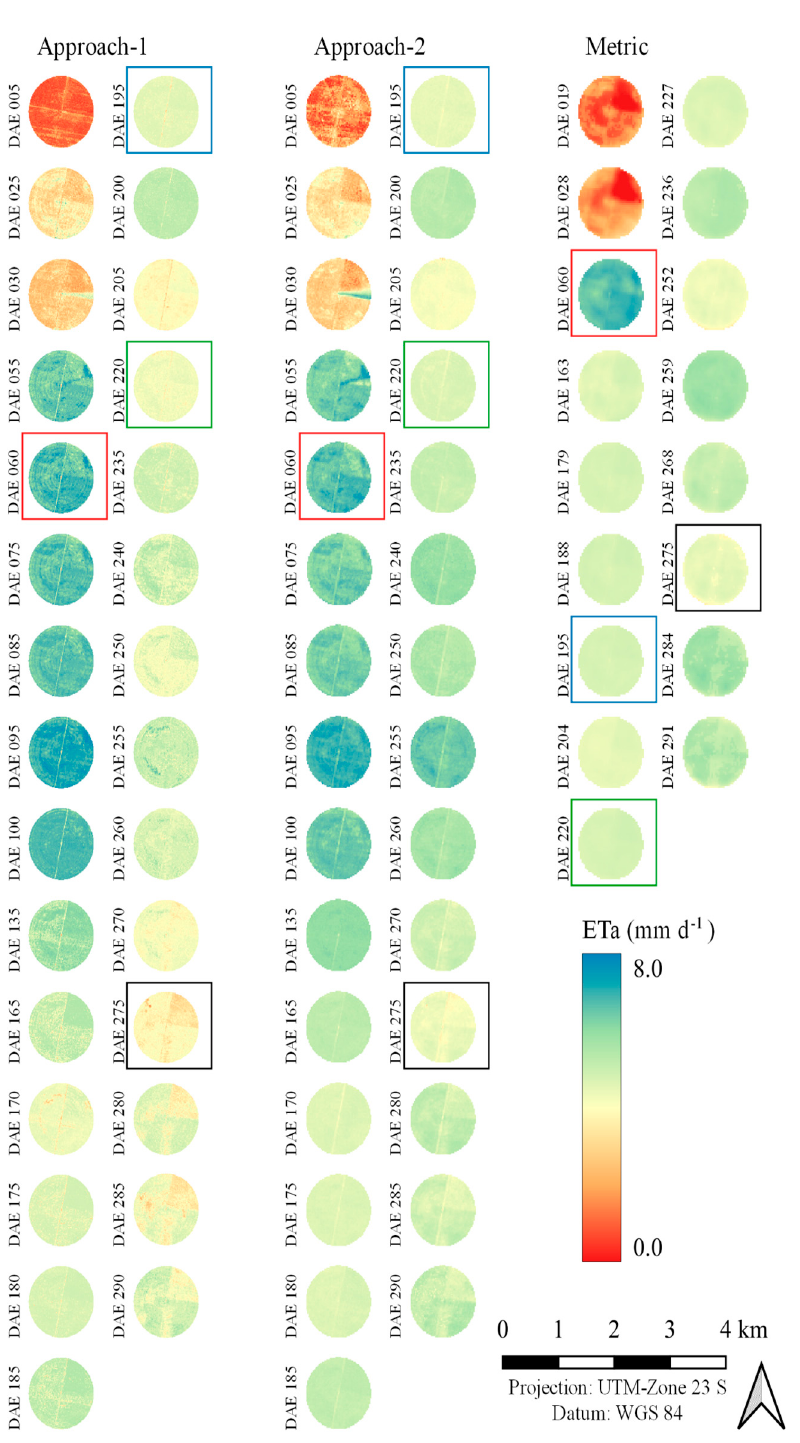
Figure 11. Sugar cane temporal-spatial actual evapotranspiration in three different spatial resolutions evincing, through rectangles, coincident dates between Sentinel-2 and